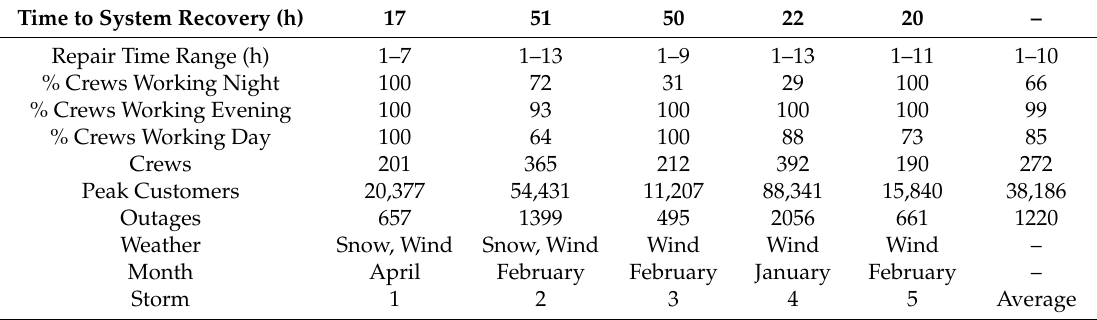
Table 1. Storms used for model validation. The repair time range column is validated from the model and can be seen in Figure 4. The system recovery column is from historic storm